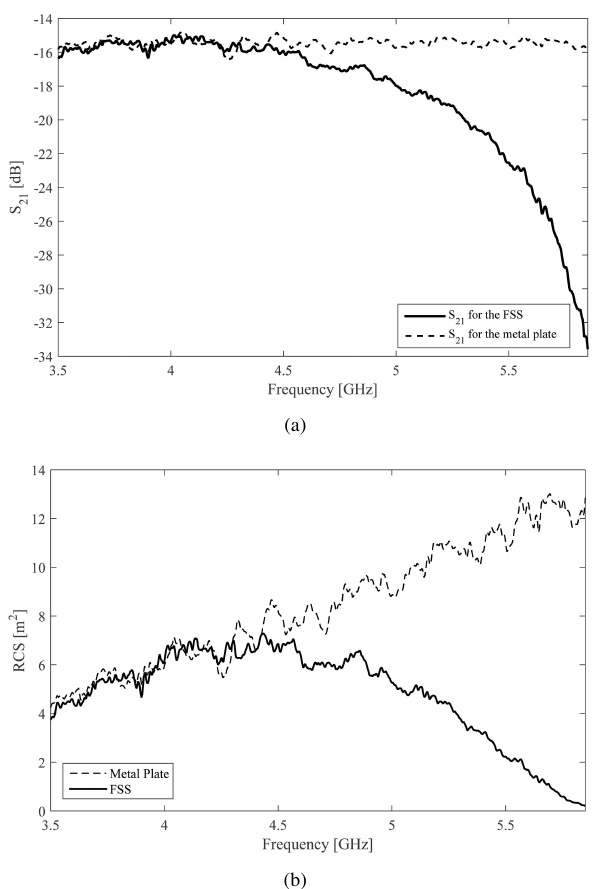
Figure 11: (a) Measured S 21 for the FSS and Metal Plate; (b)Measured RCS for the FSS and metal